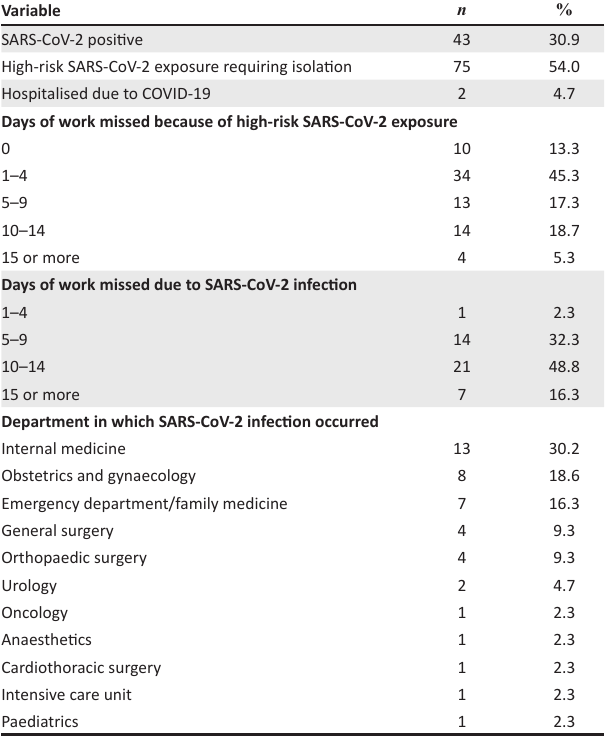
TABLE 2: SARS-CoV-2 exposure and infection.